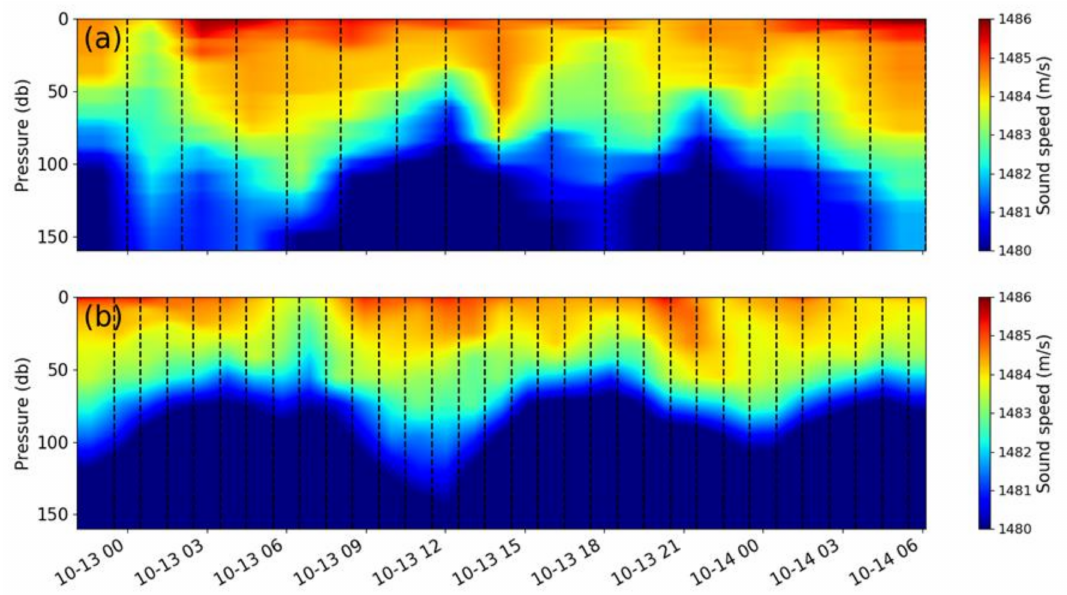
Figure 6. Comparison of the sound speed field as function of pressure for the period when the CCGS Vector was near the Sooke mooring. ( a ) Observed sound speed field and ( b ) the field obtained from the SalishSeaCast model data. The dashed lines indicate the times of the available